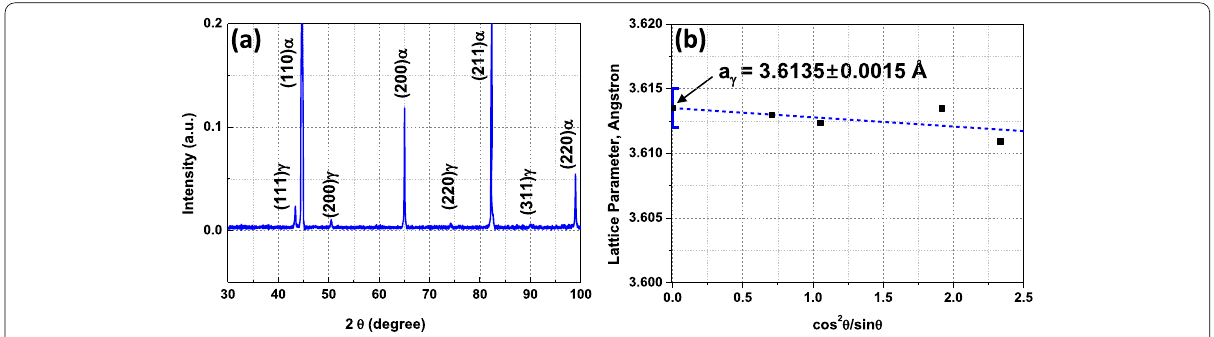
Fig. 11 XRD spectrum and the lattice parameter‑cos 2 θ/sinθ